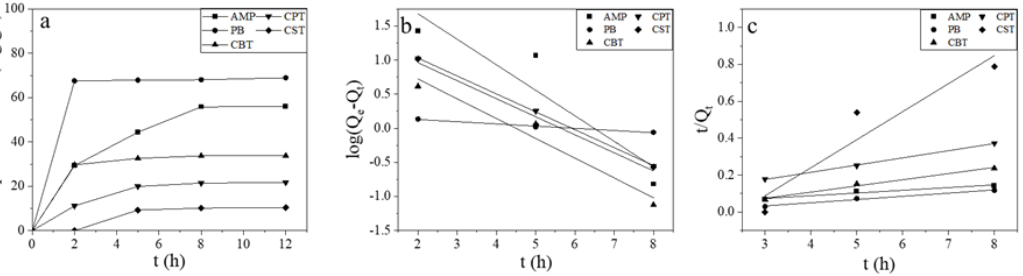
Figure 5. ( a ). Adsorption amounts with time ( b ). Fitting of pseudo-first-order dynamics model, ( c ). Fitting of pseudo-second-order dynamics